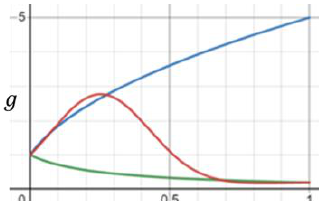
Figure 9. Thermal conductivity functions 𝑔(𝜃) = 1/(4𝜃 + 1) (green), 𝑔(𝜃) = √24𝜃 + 1 (blue), and 𝑔(𝜃) = exp(1 − 16(𝜃 − 1/4) 2 ) + 𝜃/5 (red).